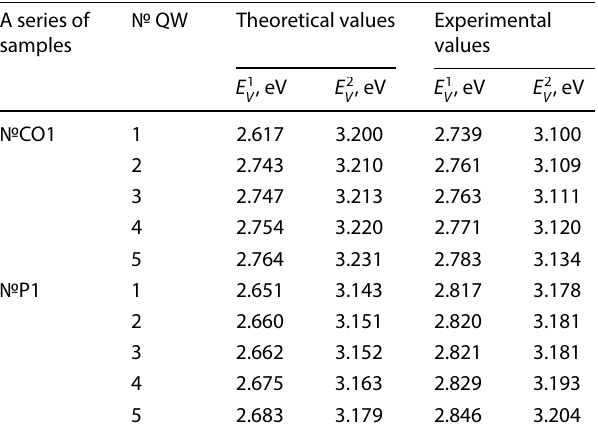
Table 3 Values of quantum size energy levels in the active layer InGaN/GaN A series of № QW Theoretical values Experimental samples